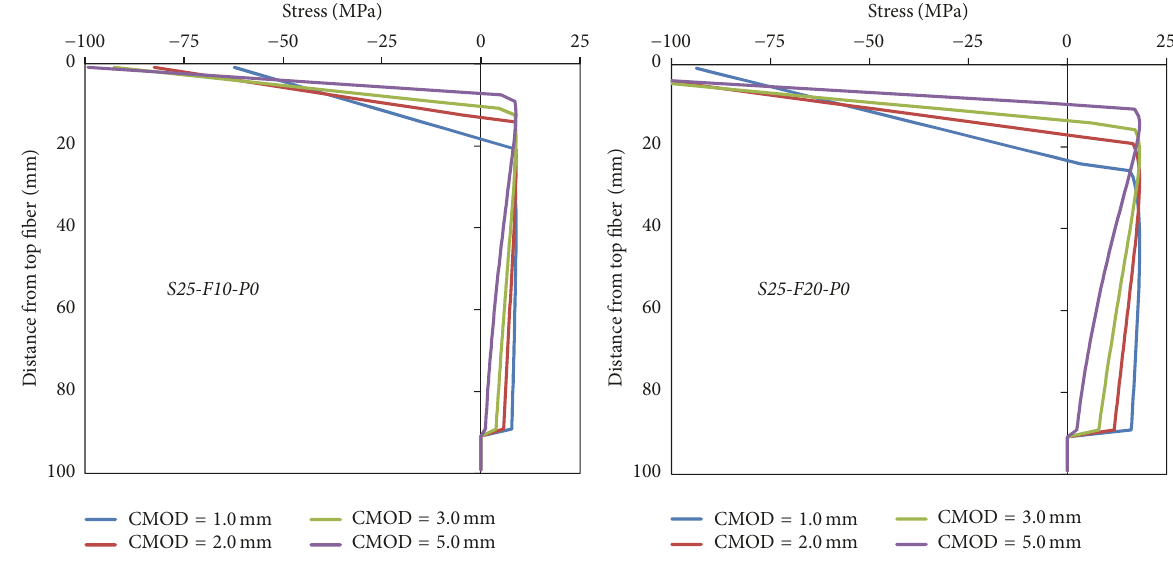
Figure 8: Stress distribution along the section with a